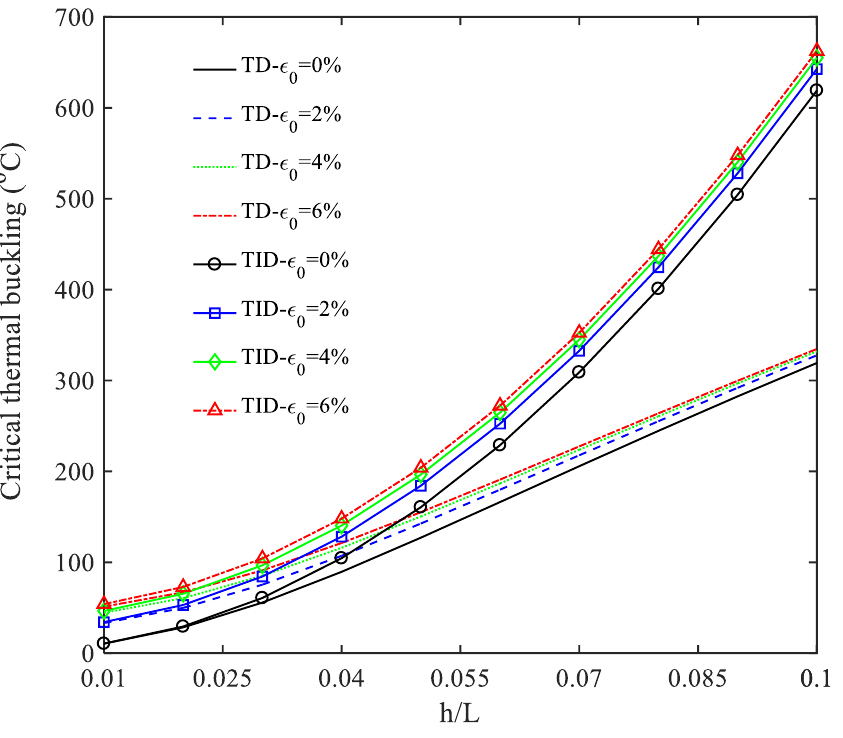
Figure 3. Variation of the critical thermal loading vs. h / L for TD and TID properties, and different values of ε 0 ( n = 1, h c / h = 0.8 and V SMA = 0.2).